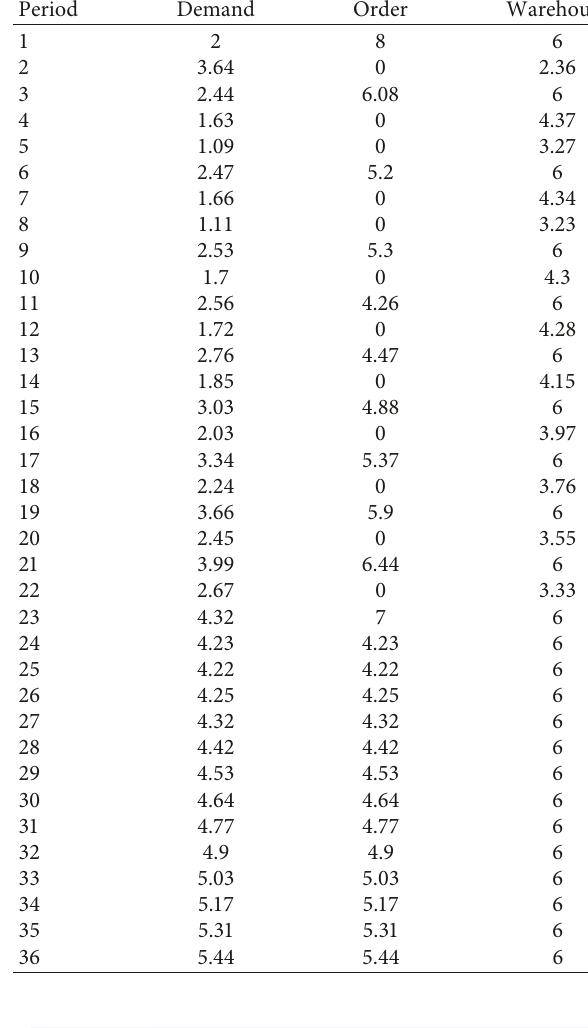
Table 5: Demand, order, and wholesaler warehouse by the ex- ponential smoothing